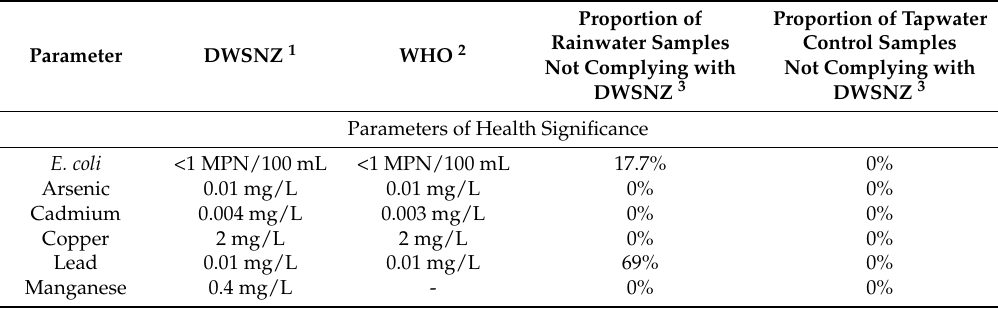
Table 8. Summary of study results in relation to drinking-water